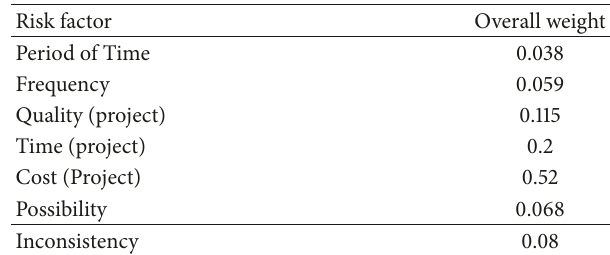
Table 2: Final weight of